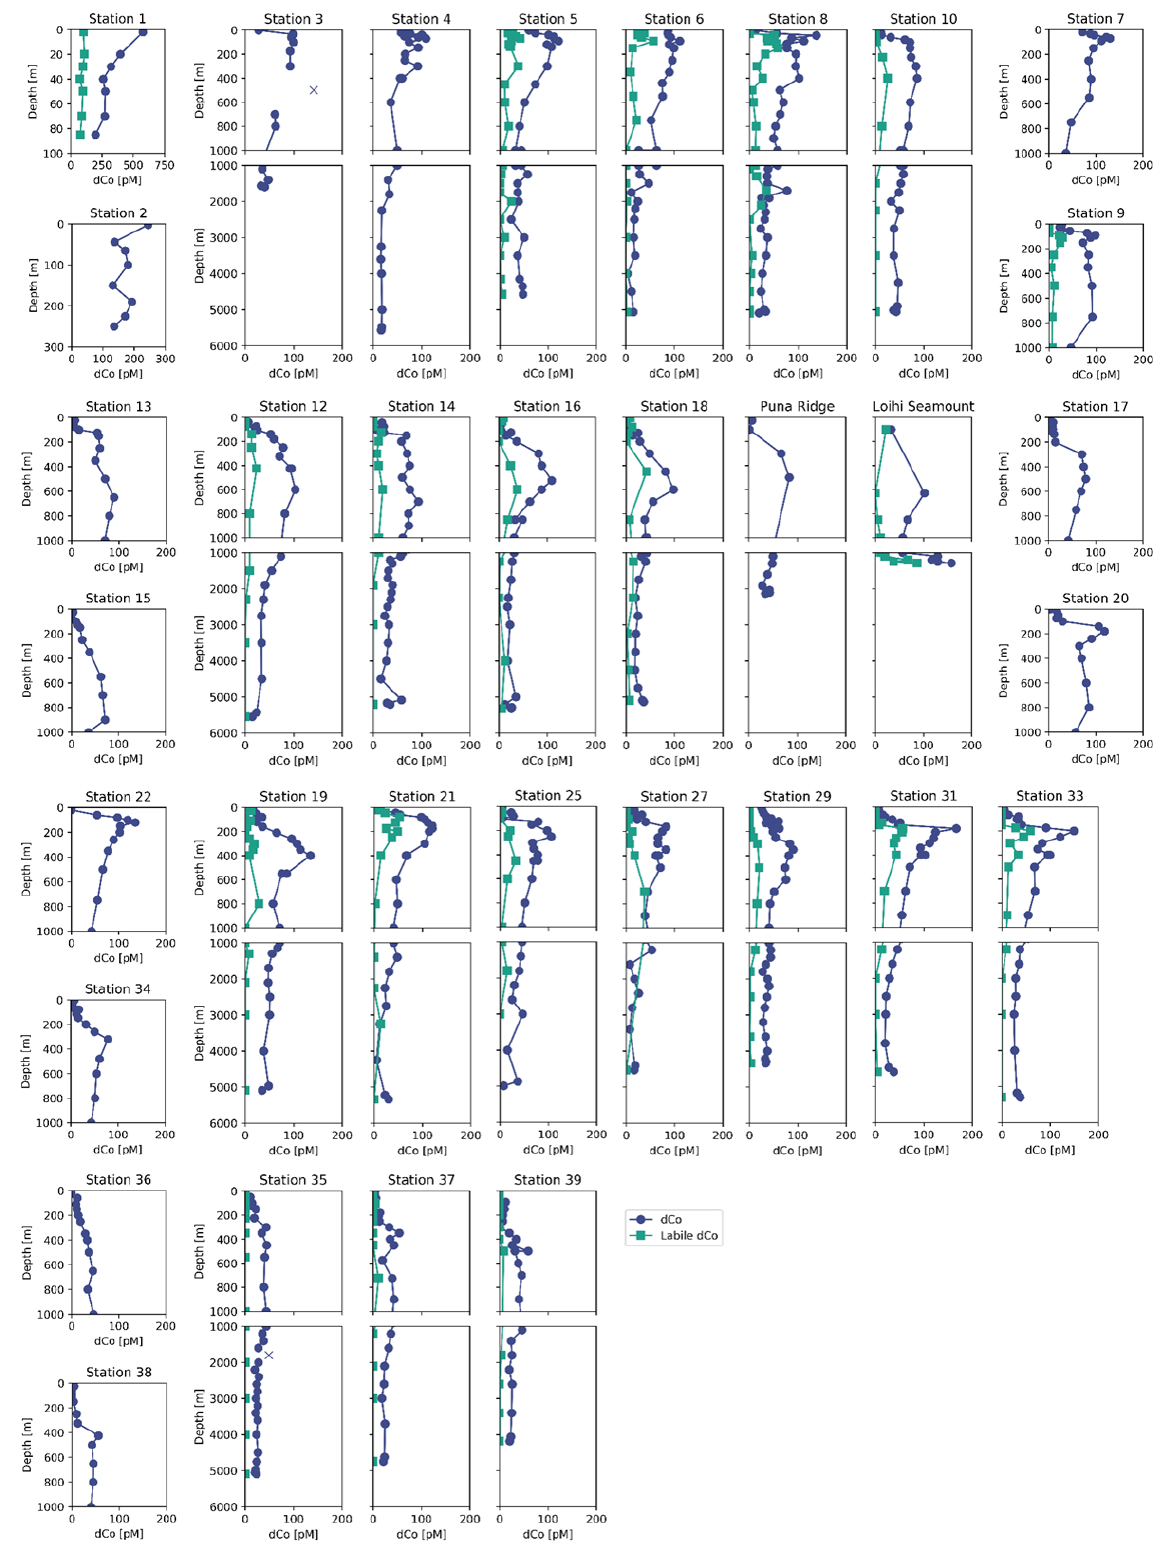
Figure 4. Depth profiles of dissolved Co (navy circles) and labile dissolved Co (teal squares) along the GP15 Pacific transect. Suspected outliers are marked as an